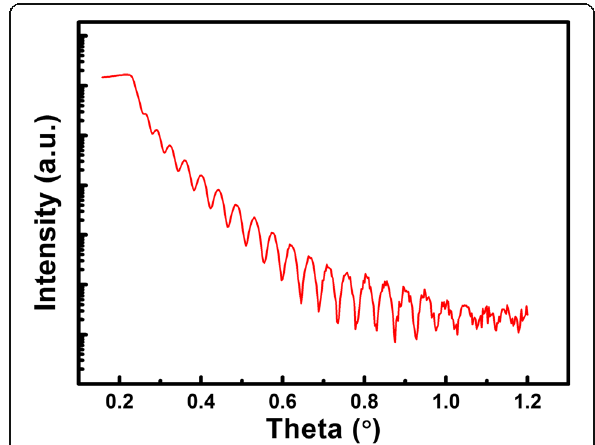
Fig. 5 XRR measurement of the 87-nm AlN thin film